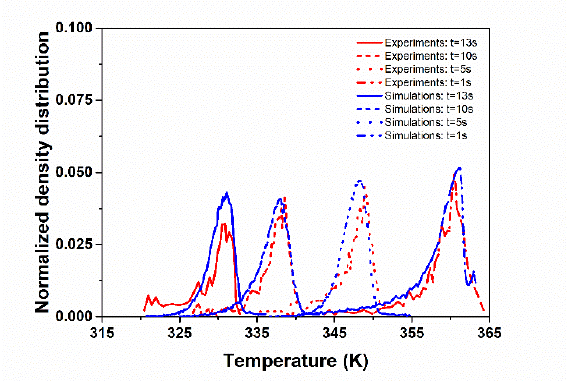
Figure 6. Temperature distribution of particles obtained from experiments [24] and from CFD–DEM method.